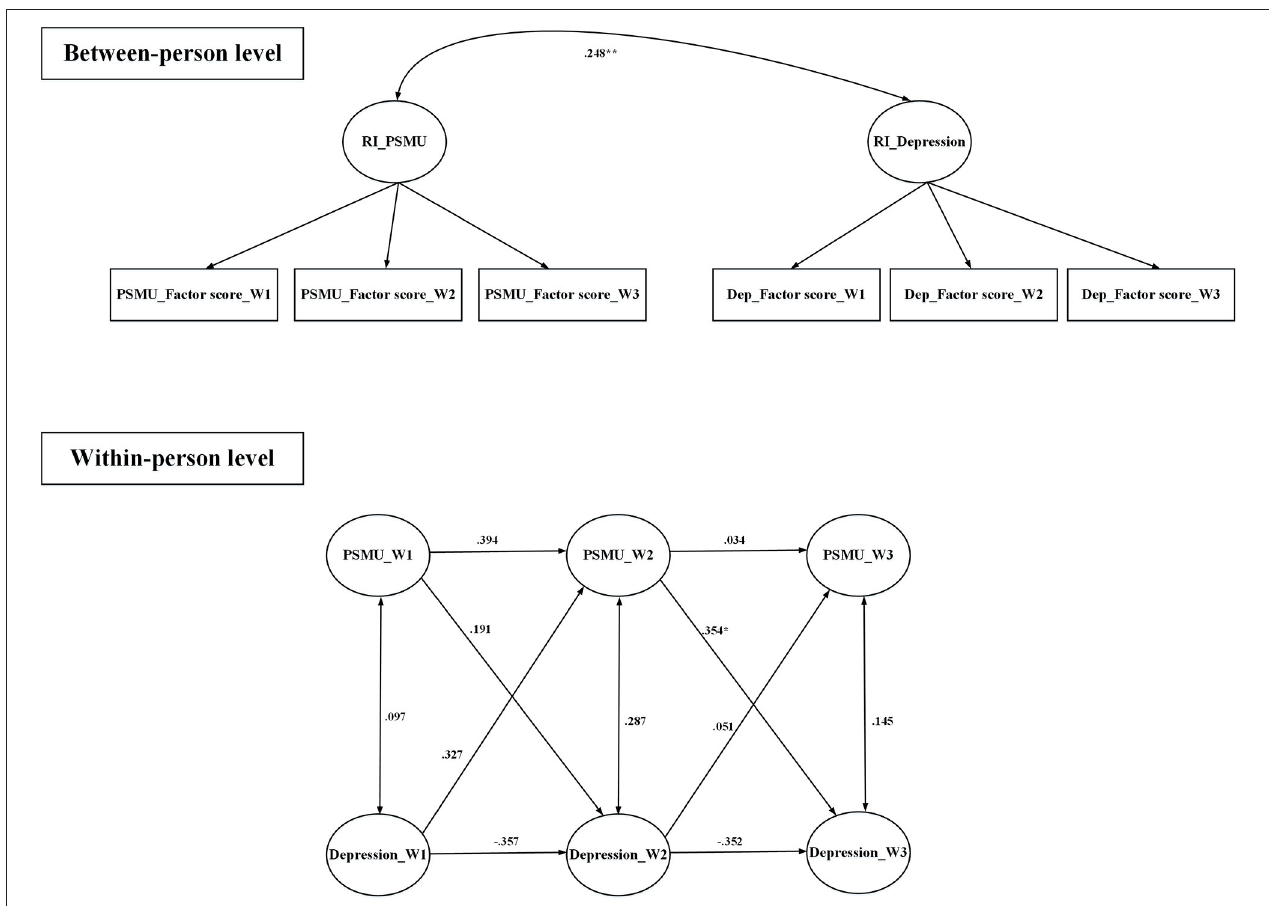
FIGURE 2 | Cross-lagged model of PSMU and depression using lagged bidirectional model. Covariates include gender and age. Depression was assessed using the Hospital Anxiety and Depression Scale; PSMU, problematic social media use was assessed using the Bergen Social Media Addiction Scale. RI, random intercept; W1, wave 1; W2, wave 2; W3, wave 3. All the estimates are standardized coefficients. * p < 0.05; ** p <